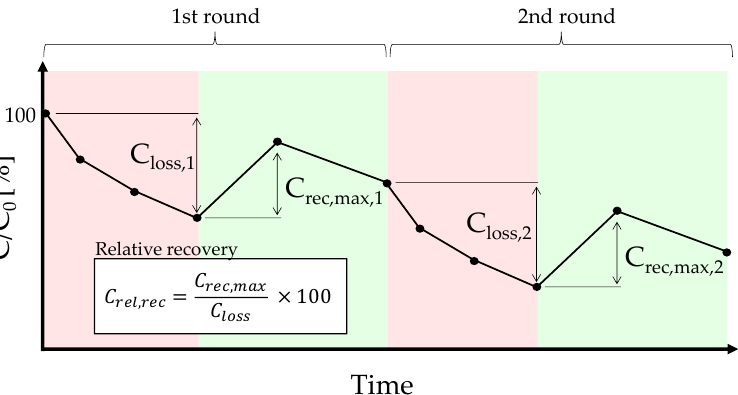
Figure A1. Schematic for the calculation of the relative recovery of apparent capacity loss and resistance increase.